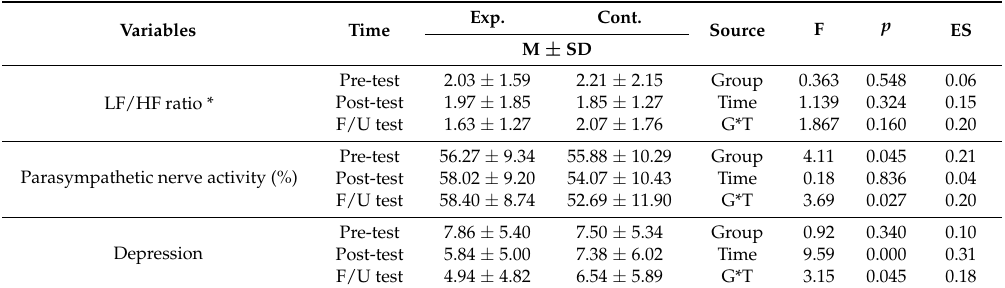
Table 4. Group comparisons of psychological health at pre-, post-, and follow-up